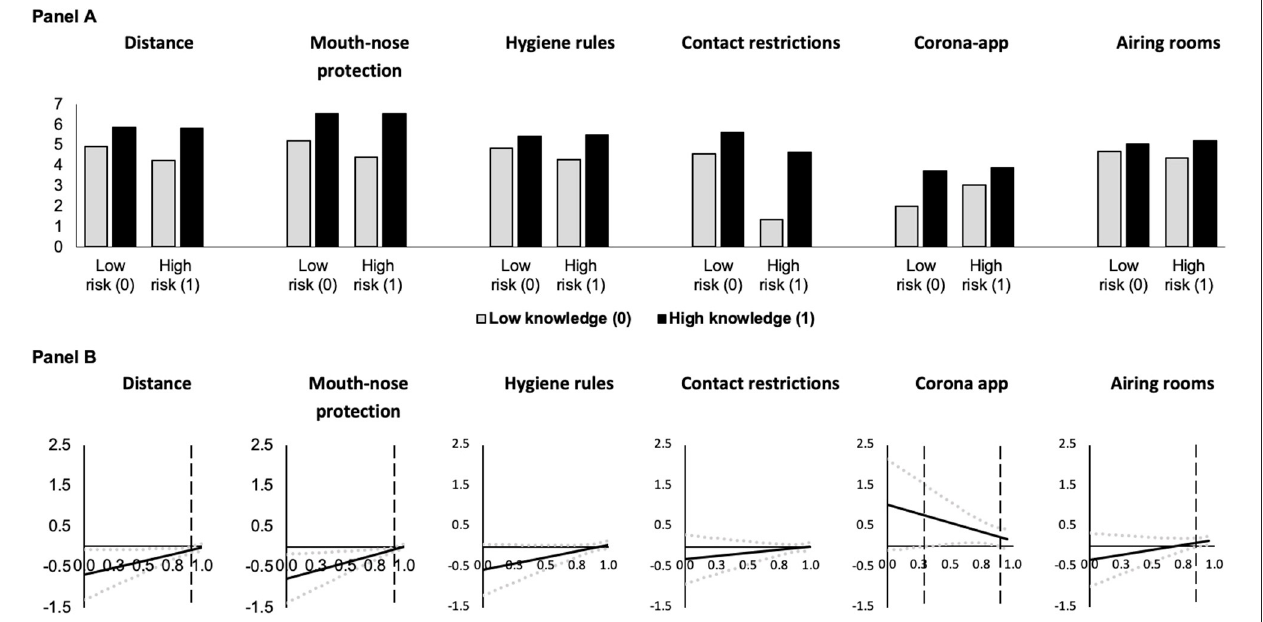
FIGURE 5 | Predicted adherence as a function of risk of severe infection at different levels of knowledge about COVID-19 (A) and conditional effect of risk of severe infection as a function of knowledge about COVID-19 (B) (based on Models 9 and 14 in Tables 6 , 7 , N = 4,096). In (A) , predictions are for men who are 18 years old who have medium levels of threat. In (B) , the black solid lines ( — ) indicate the conditional effect of risk group membership from the lowest (0) to the highest (1) level of knowledge about COVID-19 and dotted gray lines ( • • • ) indicate the upper and lower 95% confidence interval. Vertical dashed black lines indicate the Johnson-Neyman value of knowledge above which the effect of risk group membership becomes statistically insignificant ( p > 0.05). For the corona app use model, the effect of knowledge is statistically significant between the vertical dashed lines, while the effect is statistically insignificant throughout the hygiene rules and contact restrictions